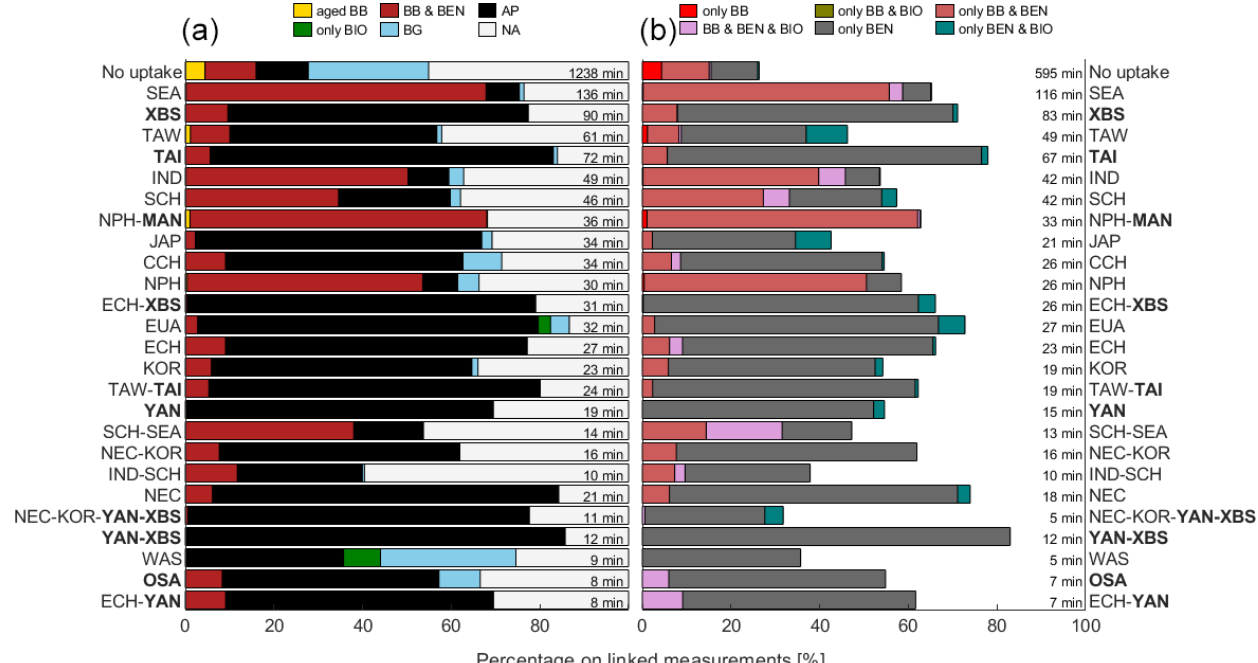
Figure 11. Like Fig. 10, just for chemical fingerprints during EMeRGe-Asia.